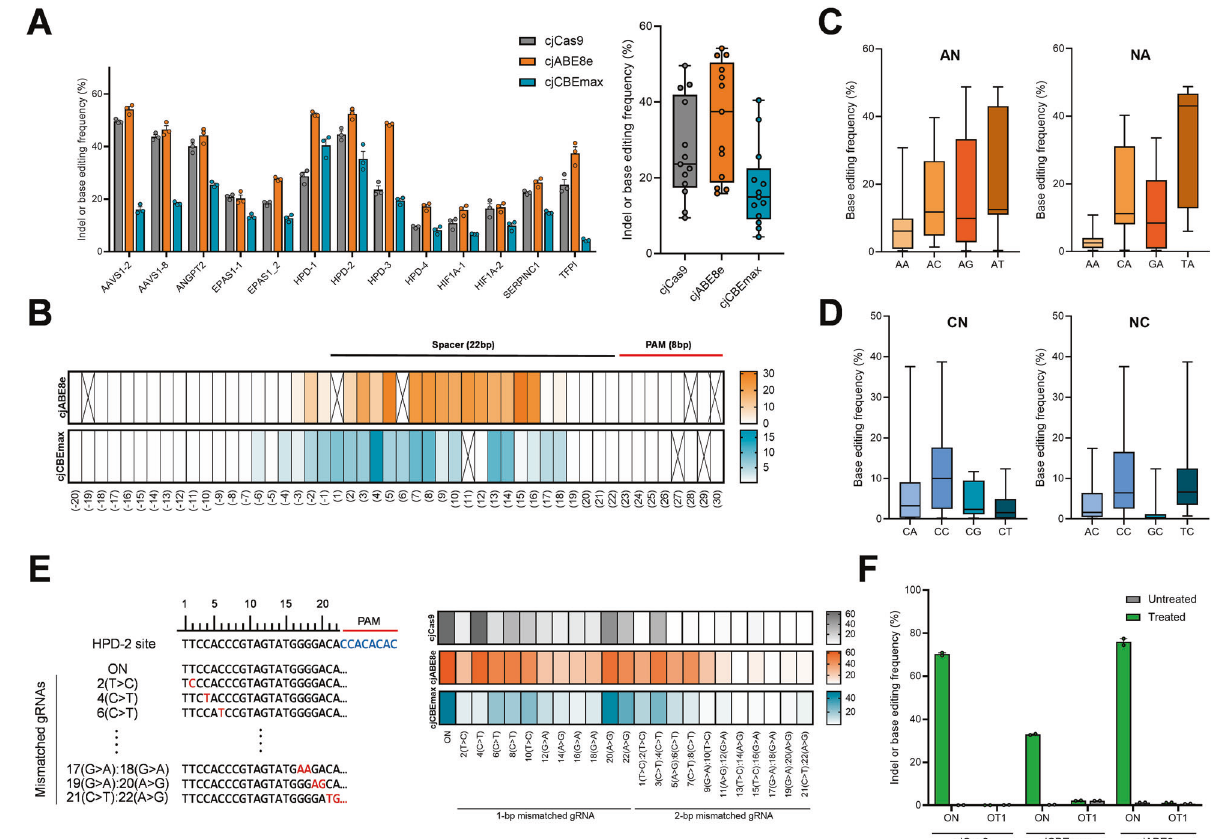
Fig. 2 Functional characterization of cjCBE and cjABE at endogenous target sites in human cells. A Bar graphs showing the mutation frequencies of each endogenous target site. The mutation frequencies of cjCas9, cjABE, and cjCBE across the 13 target sites are summarized in the right panel. B Heatmap of the base editing activity of cjABE and cjCBE within the 50-nt window across 13 endogenous target sites. The position of each nucleotide was numbered relative to the starting position of the target spacer sequences. A box with an X means there was no adenine or cytosine at those positions. Analysis of the sequence contexts around ( C ) the target adenine of cjABE and ( D ) the target cytosine of cjCBE. E The target site with PAM sequences of HPD-2 gRNA is shown in the left panel. The position of each nucleotide was designated relative to the starting position of the target spacer sequences. Mutation frequencies of cjCas9, cjABE, and cjCBE with mismatched gRNAs are shown in the heatmap in the right panel. ON means HPD-2 gRNAs with no mismatch to target sites. The numbers listed below the heatmap indicate the positions of the mismatches in each gRNA. F Analysis of potential off-target mutations of AAVS1-8 gRNAs with cjCas9, cjABE, and cjCBE. The target sequences of each site are listed in Supplementary Table 1. All experiments were conducted in biologically independent triplicates. Error bars indicate the standard error of the